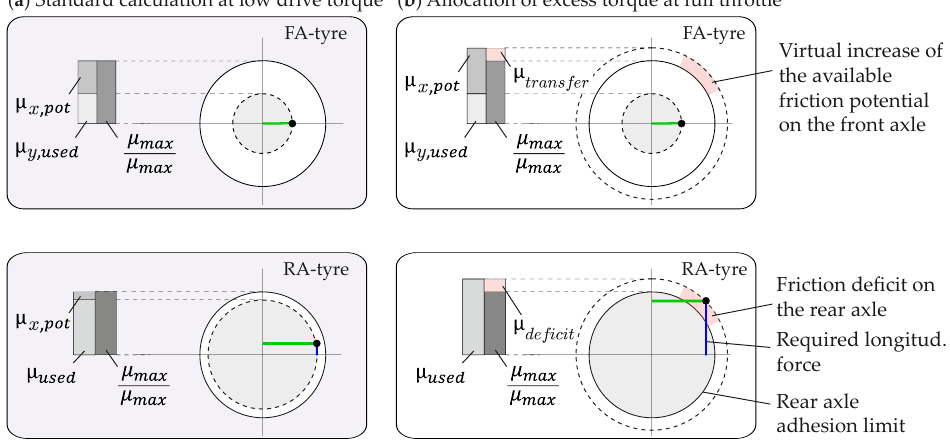
Figure 6. Concept idea—calculation of an excess torque and of a friction deficit µ deficit on the rear axle when approaching full